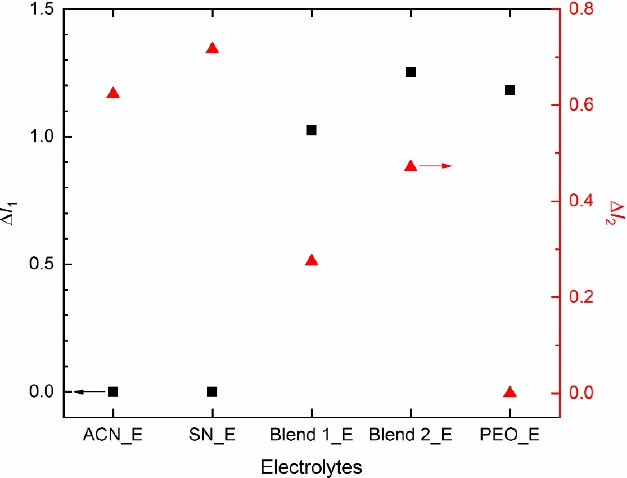
Figure 6. Relative intensities, Δ I 1 and Δ I 2 of the electrolytes. For definition, please see the text.